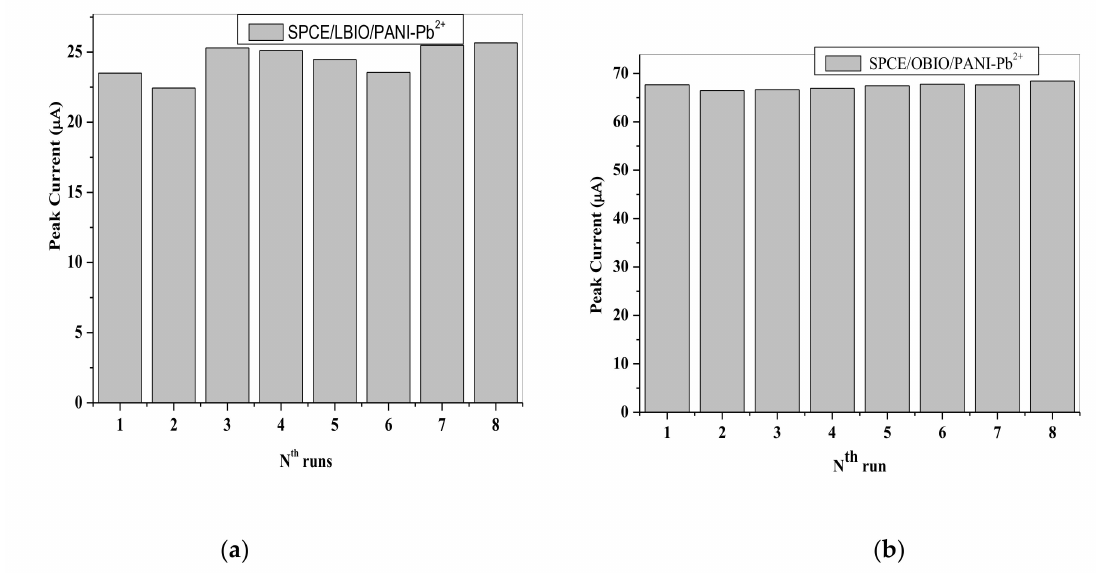
Figure 17. SWV anodic peak current magnitude for eight consecutive runs of 6.04 µ M of Pb 2+ at ( a ) SPCE/LPE/ BIONPs/PANI. ( b ) SPCE/OPE/BIONPs/PANI.